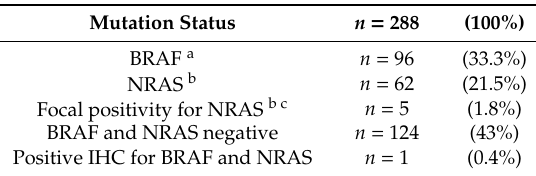
Table 2. Mutational characteristics of the whole